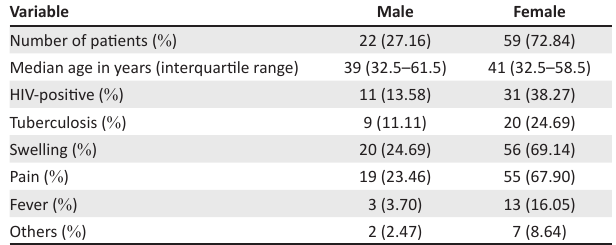
TABLE 3: Demographic and clinical profile of the patients.